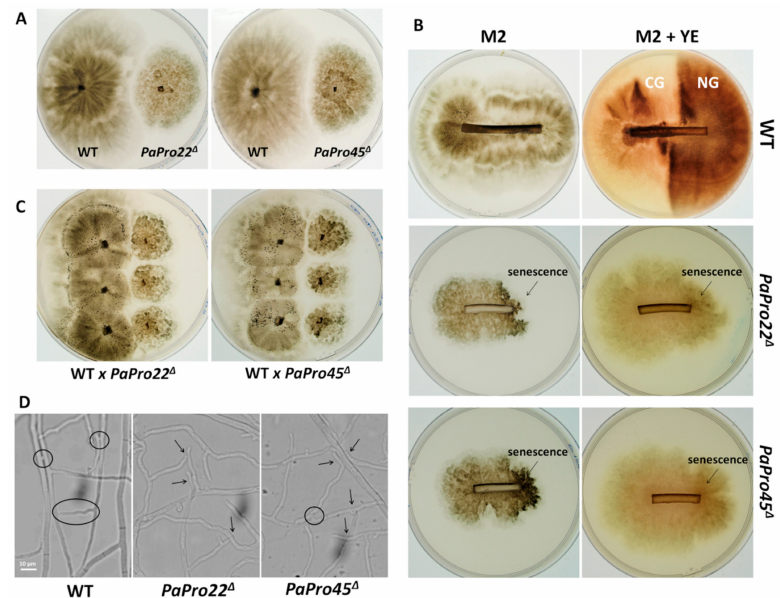
Figure 9. Phenotypes of PaPro22 ∆ and Papro45 ∆ . ( A ) The wild type (WT), PaPro22 ∆ and Papro45 ∆ were inoculated at the same time on M2 plates and the pictures were taken ten days later. PaPro22 ∆ and Papro45 ∆ have a slow growth, are devoid of aerial hyphae, but accumulate pigments. ( B ) CG test were made as those of Figures 1 and 7. Apical hyphae of PaPro22 ∆ and Papro45 ∆ show after 3–4 cm the arrest of growth and accumulation of dark pigments typical of senescence. ( C ) Sexually compatible mycelia of the indicated genotypes were inoculated on M2 and three days later 2 mL of water were added to spread spermatia. The wild-type thalli differentiated after seven days mature perithecia, but not the mutant ones, showing that PaPro22 ∆ and Papro45 ∆ were -sterile and -fertile. Perithecia are the small ♀ ♂ black dots. ( D ) Anastomoses (open circle) are frequent in the wild-type, but very rare in PaPro22 ∆ and Papro45 ∆ (a field in which one figure of anastomose was seen is shown for the Papro45 ∆ mutant, in most fields anastomoses could not be observed). Hyphae from PaPro22 ∆ and Papro45 ∆ often meet, but do not engage cell fusion